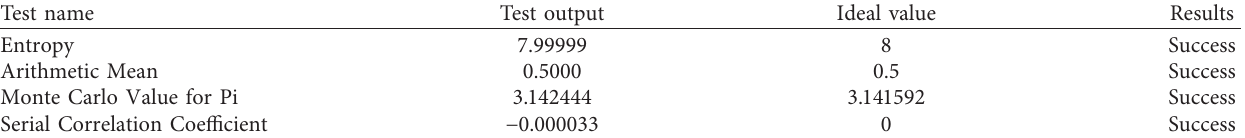
Table 3: The results of ENT test